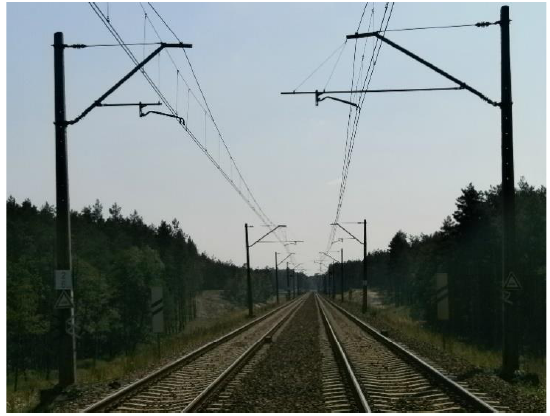
Figure 4. An example of a state-space interface of the railway track geometry system with the electrified traction system, the geometric configuration of object Nos. R 143_1_1 and R 143_1_2 . The contact line stagger is a structural offset of the contact wire and the contact line from the railway track axis at the point of suspension of the contact line [43] in the horizontal plane. As a result of alternate staggering, the stagger of the contact line (zigzagging, zigzagging of the network) is achieved. A stagger of the contact line gives the contact wires offset Z ig , both from and to the pole (supporting construction of traction contact line, supporting construction), the points of successive suspensions (Figure 5).